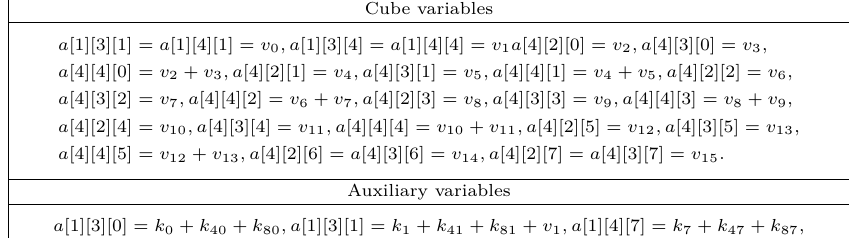
Table 7: The first two 16-dimensional cubes for Ketje Jr V1, where the corresponding ( n a , n i ) are (17 , 18) and (21 , 22), and ( n 0 accumulated numbers of key bits recovered are 35 and